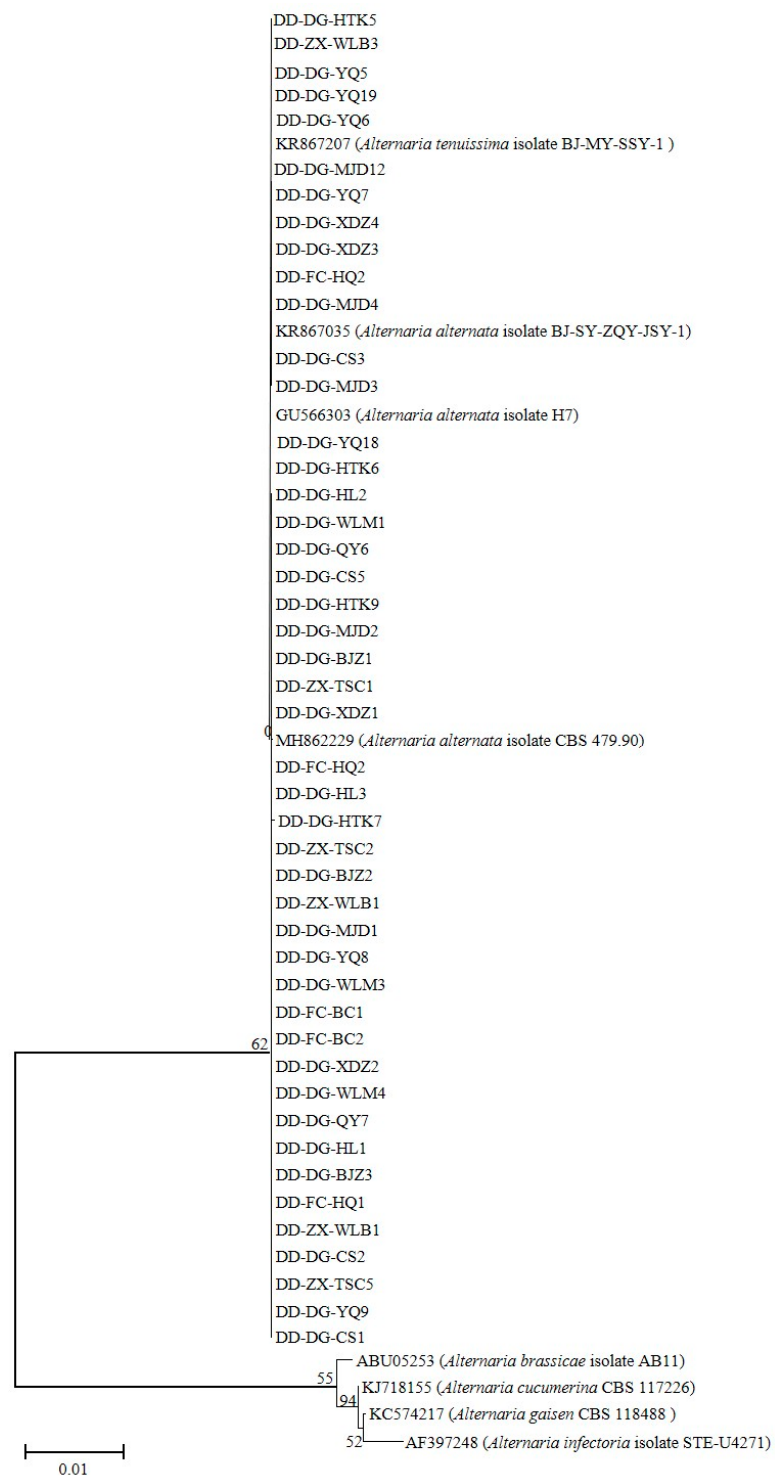
Figure 2. Phylogenetic tree based on the partial coding sequences of the ITS gene of the 46 Alternaria isolates used in the pathogenicity tests and the 8 reference sequences published in the NCBI library. The algorithm is based on the Maximum Likelihood estimate. Bootstrap values with 1000 replica- tions were found at nodes on the phylogenetic tree, which identified the A. brassicae isolate AB11, A. cucumerina CBS 117226, A. ganisen CBS 118488, and the A. infectoria isolate STE-U4271 (AF397248) as